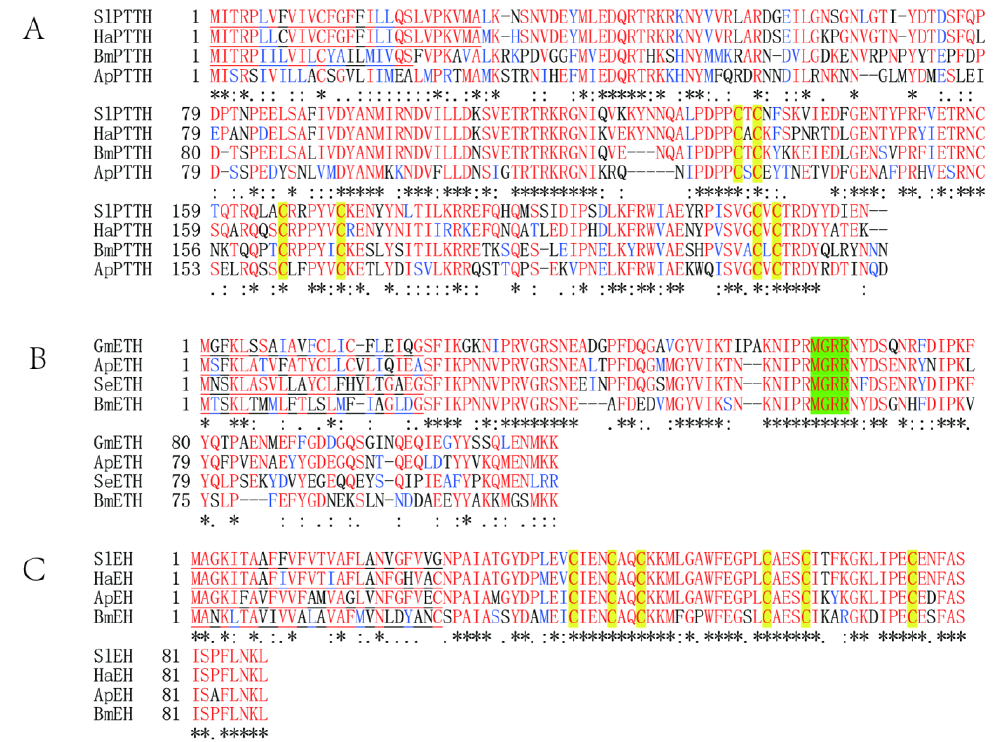
Figure 4. Sequence alignment of the deduced amino acid sequences of PTTH ( A ), ETH ( B ), and EH ( C ). Species abbreviations and accession numbers of the sequences used in the alignment are as follows: SlPTTH— Spodoptera litura (XP_022816485.1), HaPTTH— Helicoverpa armigera (AAP41131.1),